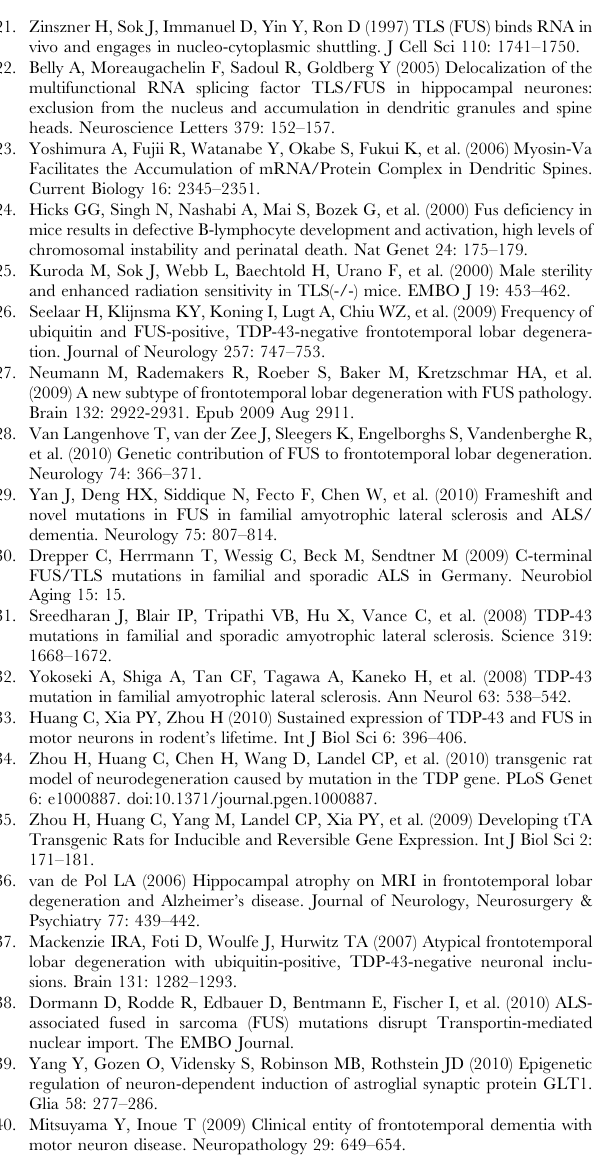
Figure S4 Colocalization of ubiquitinated aggregates with mitochondrial marker in FUS transgenic rats. a-c, Double- fluorescence labeling shows that ubiquitinated aggregates (a) were colocalized with the mitochondrial marker COXIV (b) in the frontal cortex of a mutant FUS transgenic rat at paralysis stage. Arrows point to COXIV stained structures inside a cortical neuron. Scale bars: 10 m m. Table S1 A summary of human FUS transgenic rat lines created. Multiple lines of transgenic rats were created by pronuclear injection of human FUS transgene and two mutant FUS transgenic lines developed disease